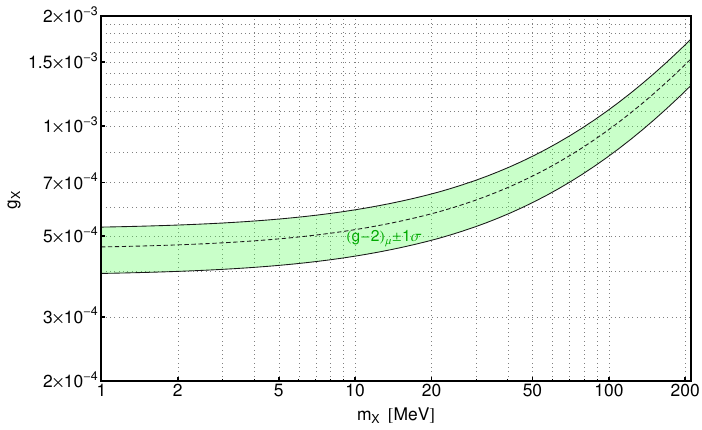
Figure 1 . The ball park parameter space (cid:12)tting (cid:1) a (cid:22) allowing the 1 (cid:27) uncertainty. The 1 (cid:27) uncer- tainty is estimated by (cid:1) (cid:27) = p 63 2 + 43 2